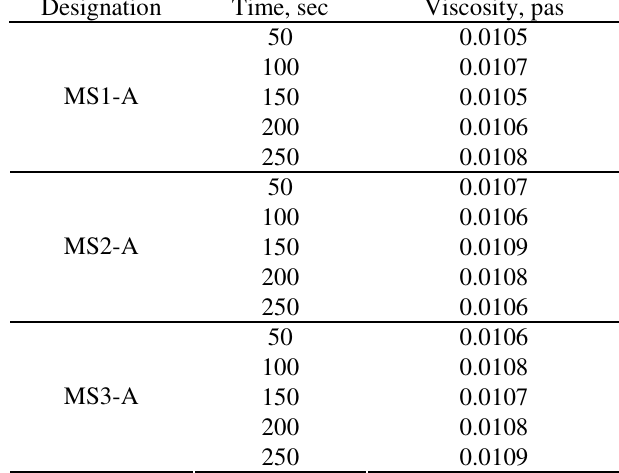
Table 5. Variation of viscosity with temperature of maleated shellac acrylic resin surface coating